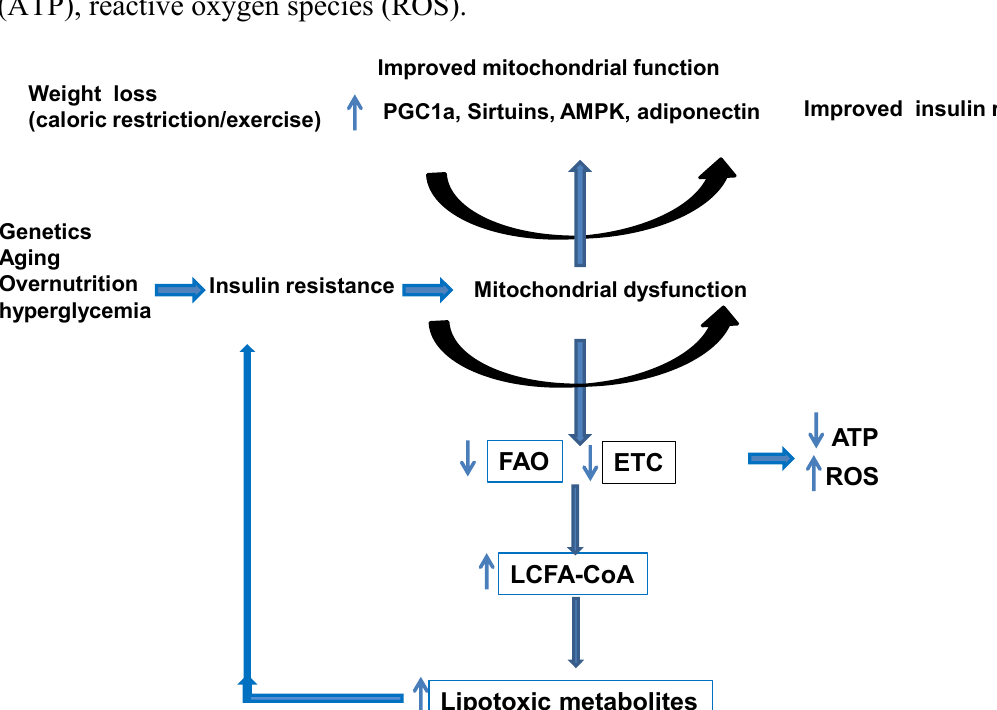
Figure 3. Role of the mitochondria in NAFLD. Impairment of mitochondrial function by genetic factors, aging, and overnutrition causes insulin resistance and mitochondrial dysfunction. Defective mitochondrial β -oxidation causes fatty liver and increases lipid toxic metabolites which may in turn causes insulin resistance, thus creating a vicious cycle between insulin resistance and mitochondrial dysfunction. Improved mitochondrial function by weight loss through caloric restriction and/or exercise improves insulin resistance. Regulators of mitochondrial biogenesis and function include genes such as peroxisome proliferator-activated receptor- γ coactivator-1 α (PGC-1 α ) and sirtuins. AMP-activated protein kinase (AMPK), fatty acid oxidation (FAO), mitochondrial respiratory chain (MRC), long chain fatty acid CoA (LCFA), Adenosine triphosphate (ATP), reactive oxygen species